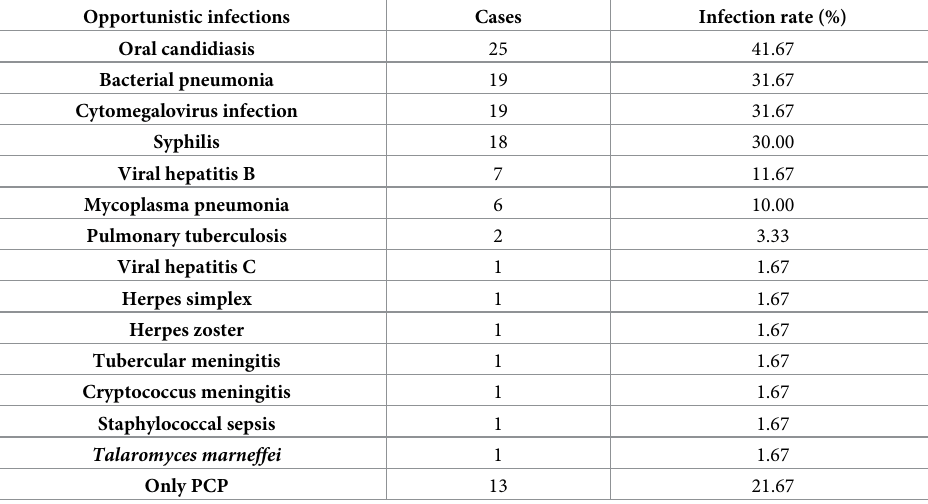
Table 1. Opportunistic infection rates of the 60 AIDS-PCP (%) patients considered in this